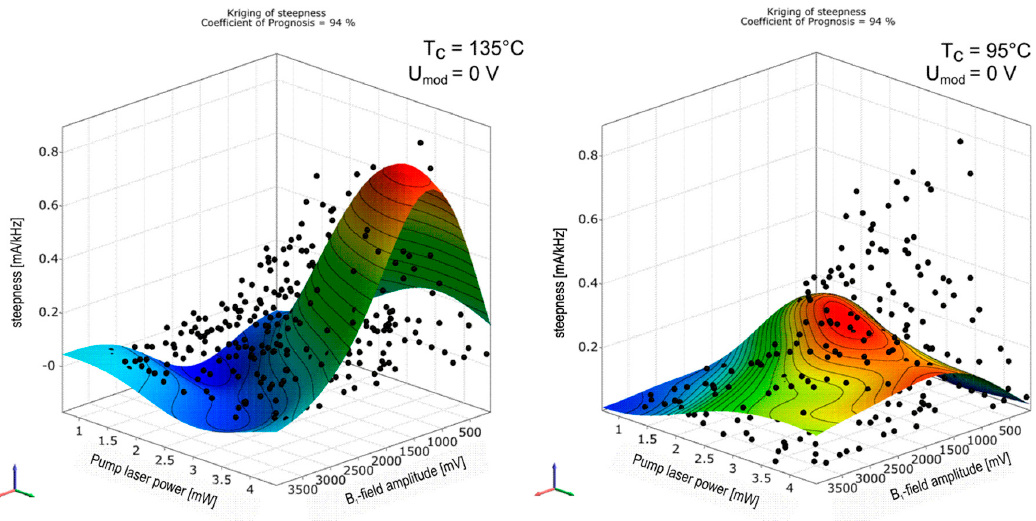
Figure 10. Response surface plot of steepness over the two input variables B 1 –field amplitude and pump laser power P L for two different cell temperatures T c . pump laser power P L for two different cell temperatures T c